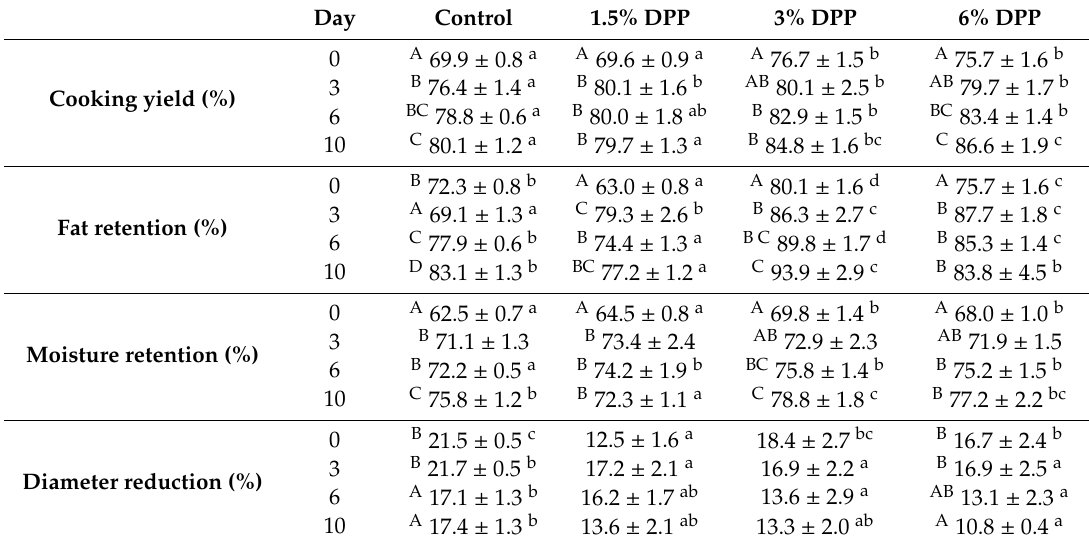
Table 4. Cooking parameters of burgers with date pit powder during refrigerated